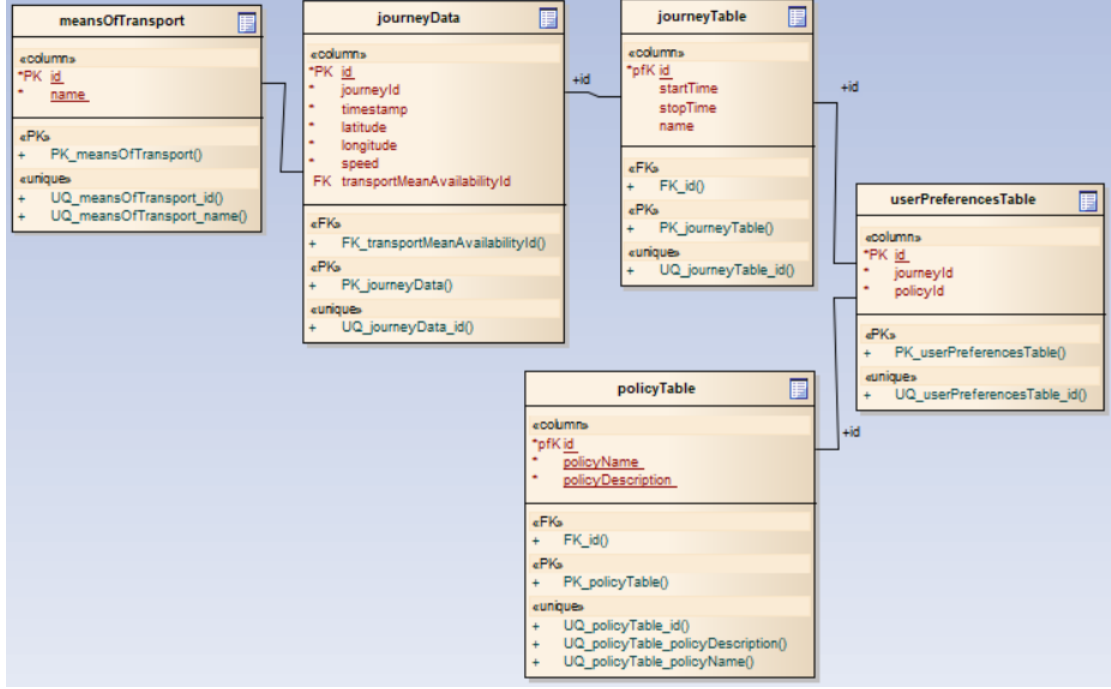
Figure 6. Database module – client